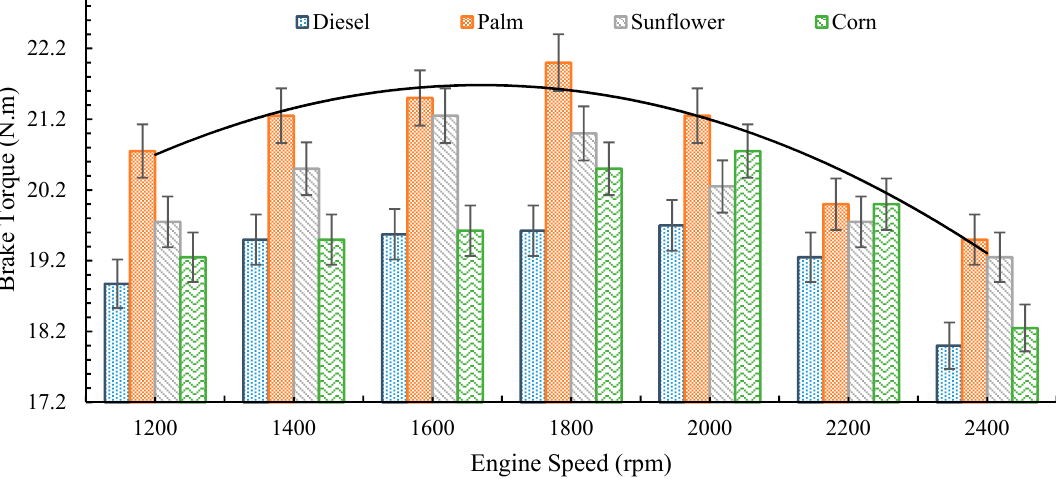
Figure 4. Variation of BT output vs. engine speed for different biodiesel blends.